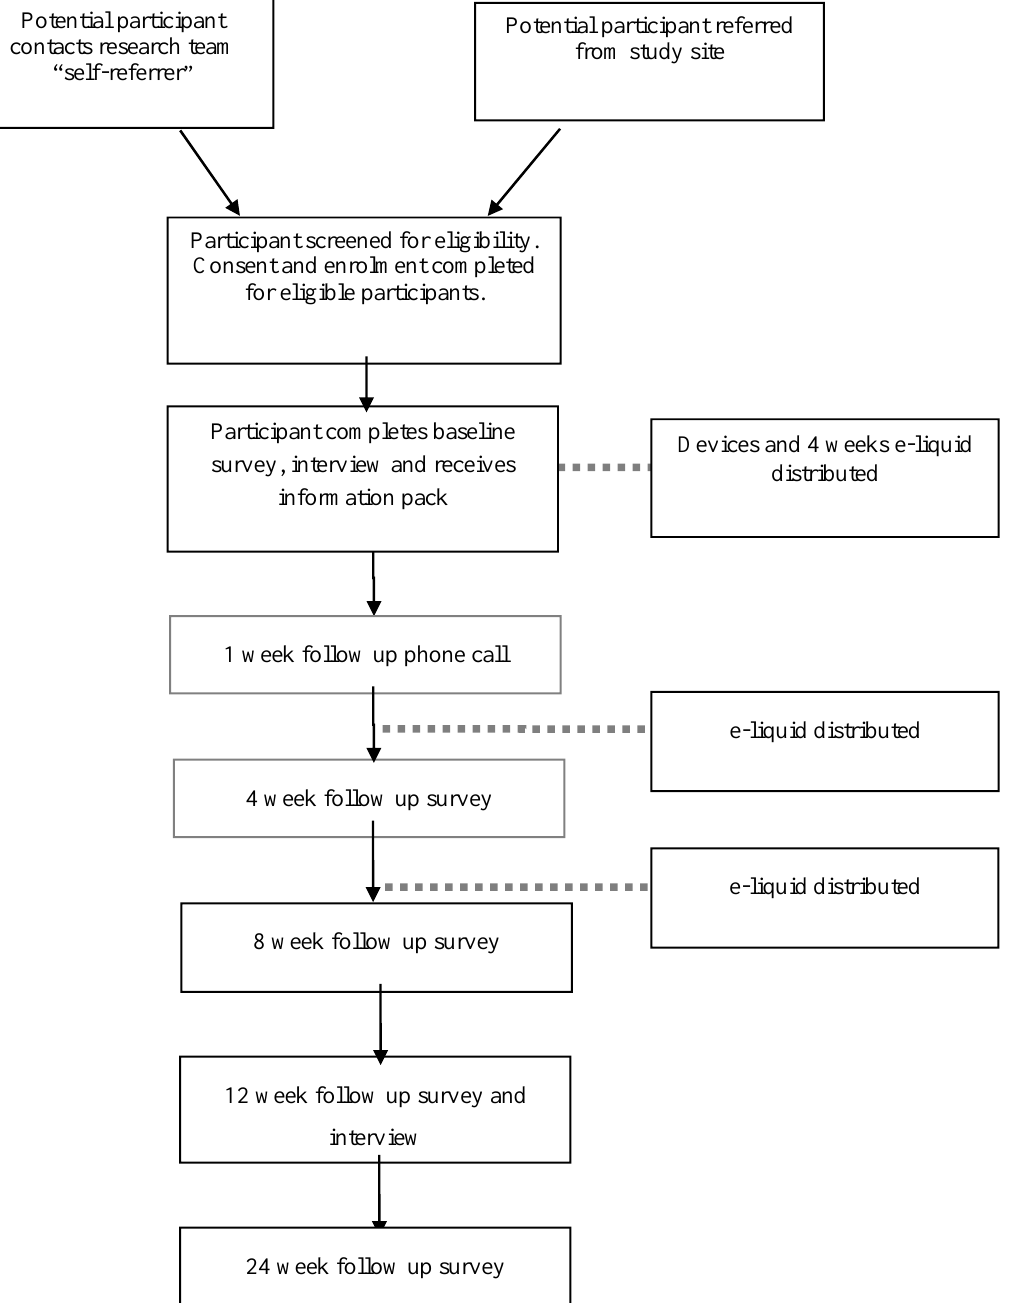
Figure 1. Study flow diagram.